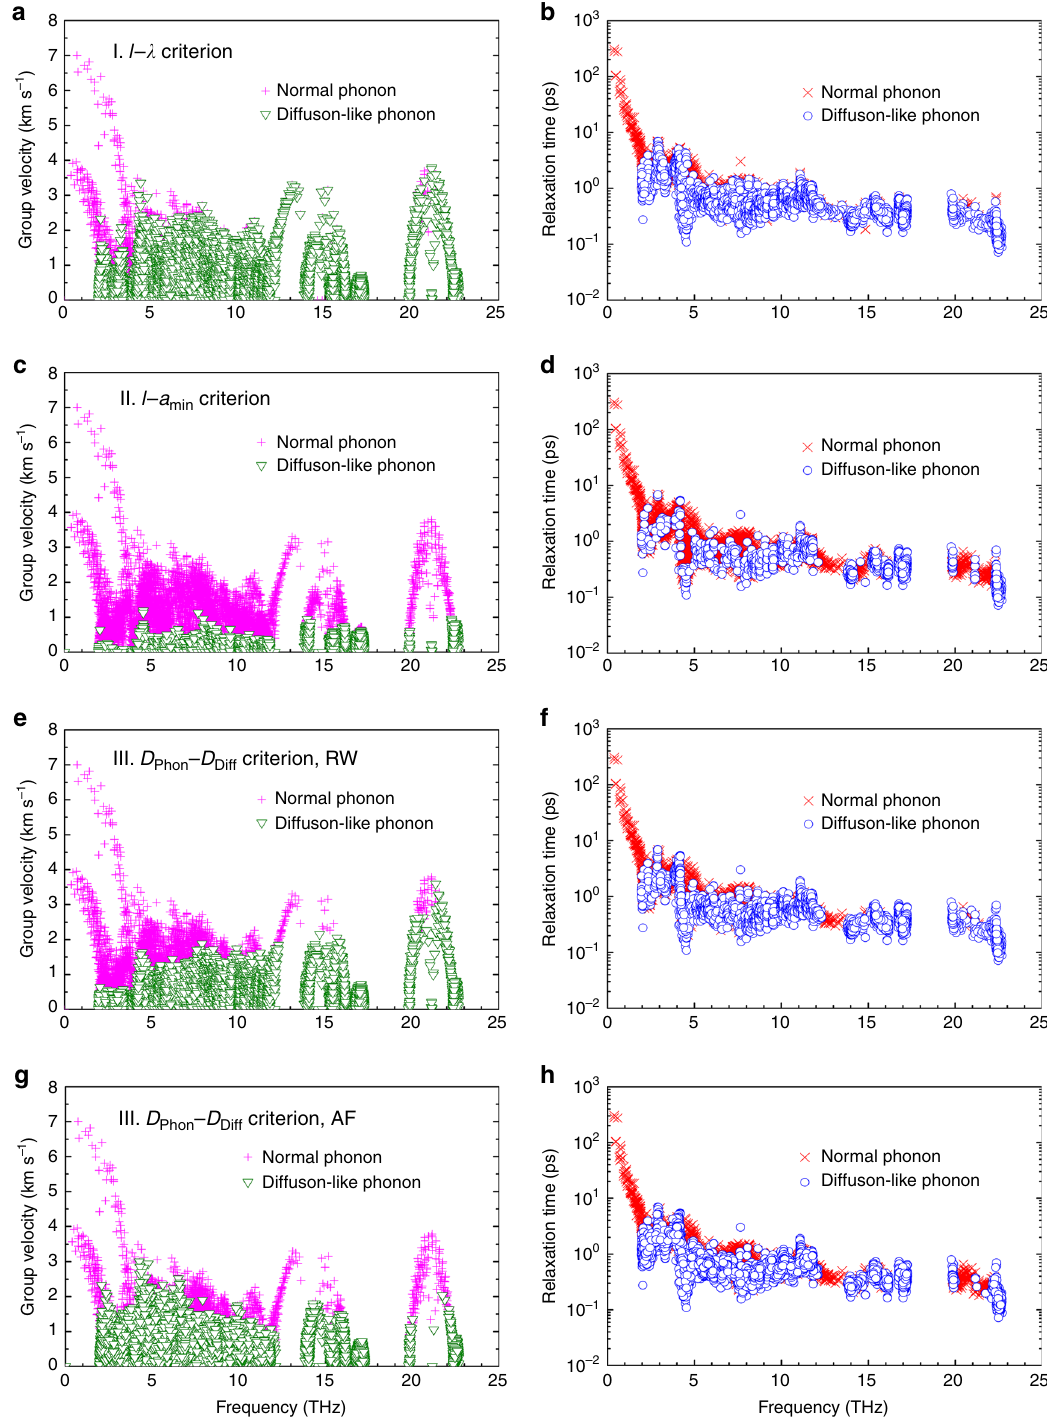
Fig. 3 Hierarchy of phonon group velocity and relaxation time. The calculated ( a ), ( c ), ( e ), ( g ) phonon group velocity ( v g ) and ( b ), ( d ), ( f ), ( h ) phonon relaxation time ( τ ) at T = 300 K for each vibrational mode of La 2 Zr 2 O 7 , based on criteria I, II, and III coupled with the random-walk (RW) theory, and III coupled with Allen – Feldman (AF) theory, respectively. Source data are provided as a Source data fi